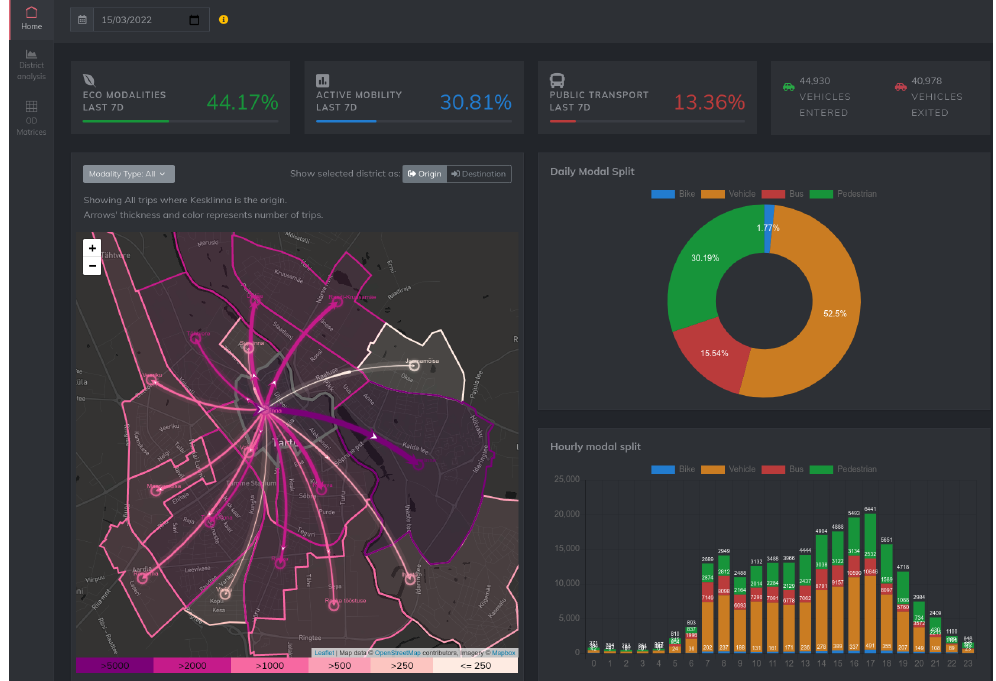
Figure 10. City-level summary perspective of the web